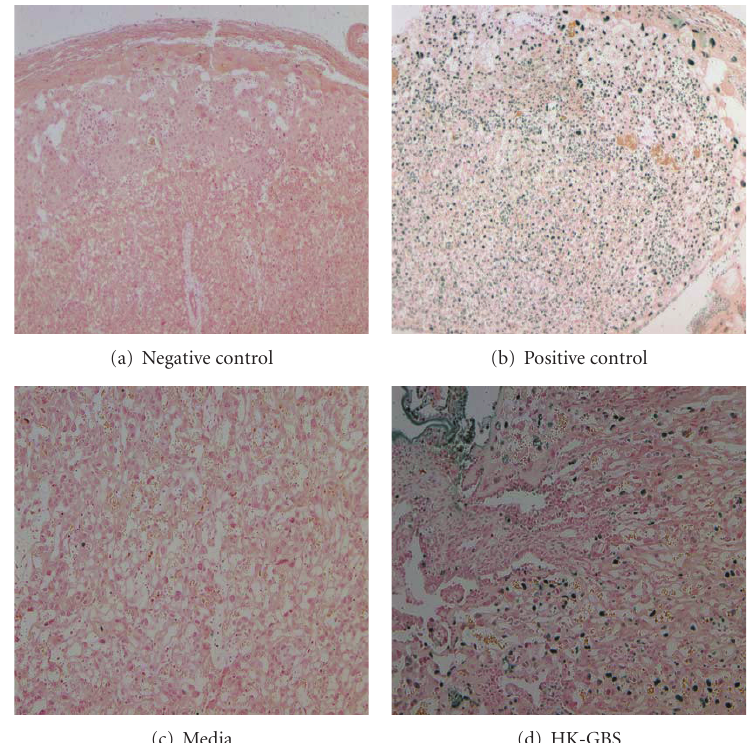
Figure 2: Intrauterine HK-GBS injection leads to TUNEL-positive apoptosis in the placenta . In the mouse placenta, there was TUNEL positive apoptosis after 14 hours of exposure to HK-GBS (d). The slides were treated with PBS for the negative control (a) and endonuclease for the positive control (b); animals were injected with media to assess baseline apoptosis levels (c). Data shown are the representative of 3 separate